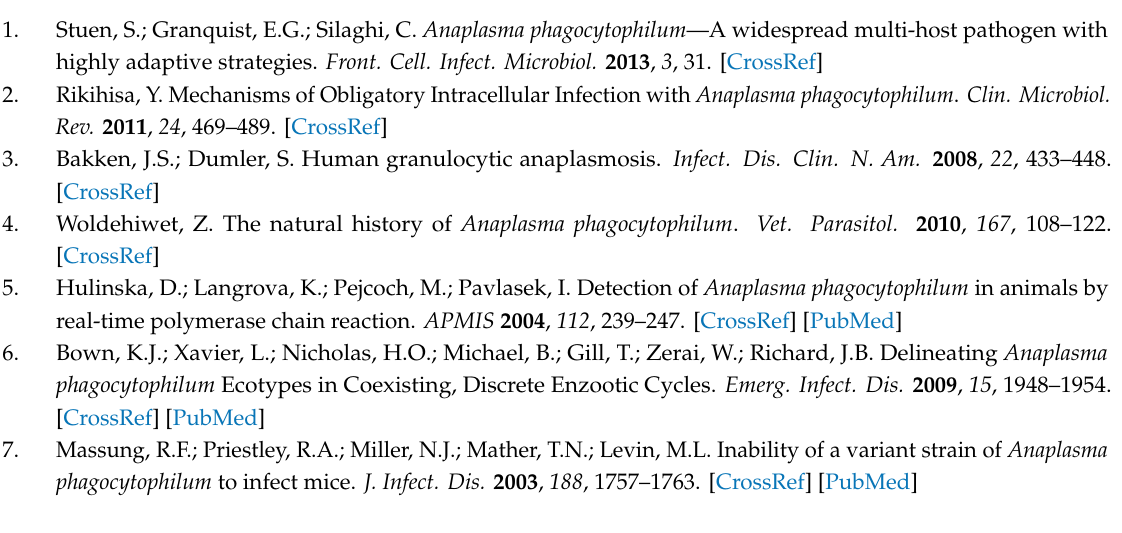
Table S1: List of rodent species captured from the three habitat areas, Table S2: Origin and list of samples on which circular consensus sequencing (CCS) and multilocus gene sequencing were performed, Table S3: GenBank accession numbers of sequences used in the phylogenetic analysis of the Anaplasma species, Table S4: Sample information for the 16S rRNA, gltA , msp4 and ankA sequences generated in this study, Figure S1: Alignment of msp2 sequences from A. platys and A. phagocytophilum , Figure S2: Representative rarefaction curves from samples tested, Figure S3: Alignment of msp4 sequences from several species of Anaplasma , Figure S4: Alignment of ankA sequences from a few Anaplasma species showing the region that was amplified in this